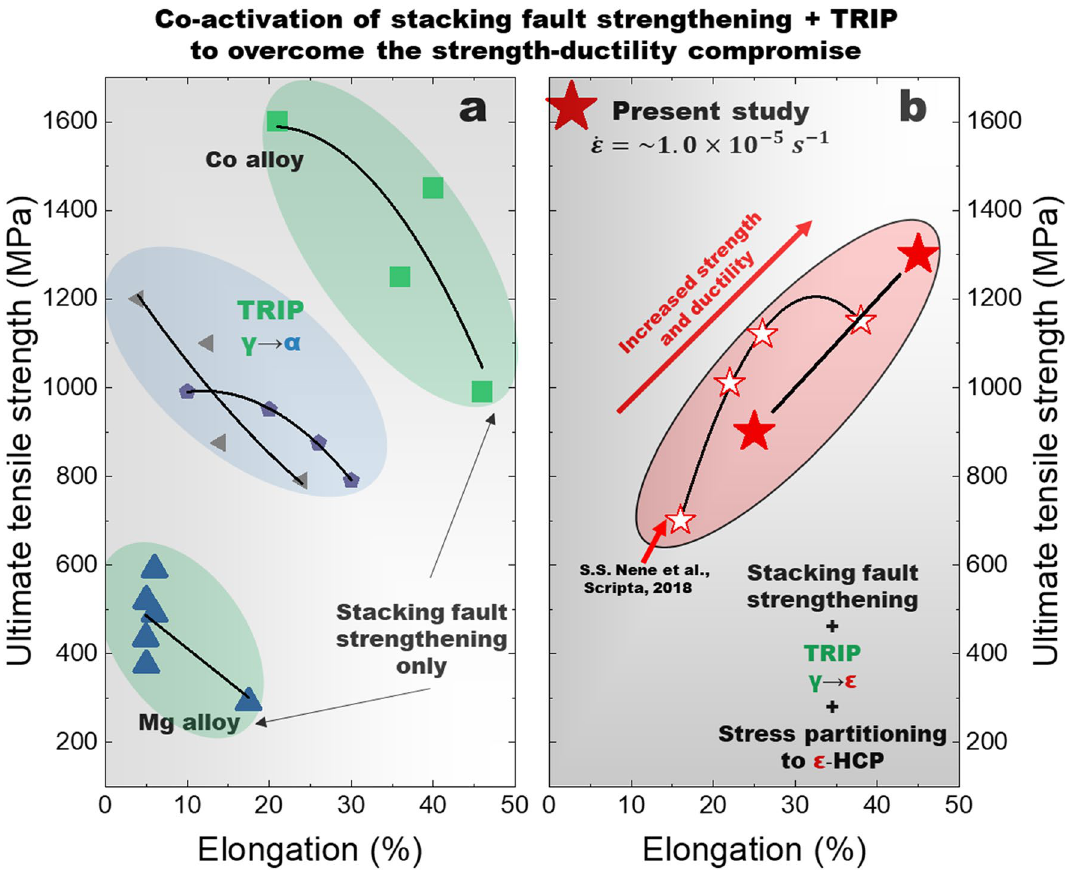
Figure 5. The combined effect of stacking fault strengthening and transformation induced plasticty (TRIP) to overcome the strength-ductility tradeoff. Strength-ductility comparison shows that activation of both SF strengthening and TRIP lead to the simultaneous increase in strength and ductiltiy observed in the present Fe 40 Mn 20 Cr 15 Co 20 Si 5 high entropy alloy. ( a ) Comparison of strength ductility combinations of TRIP steels 37,38 exhibiting the strain induced austenite to α martensite phase transformation with both stacking fault strengthened Mg 14 and Co 13 alloys ( alloy in the present study (